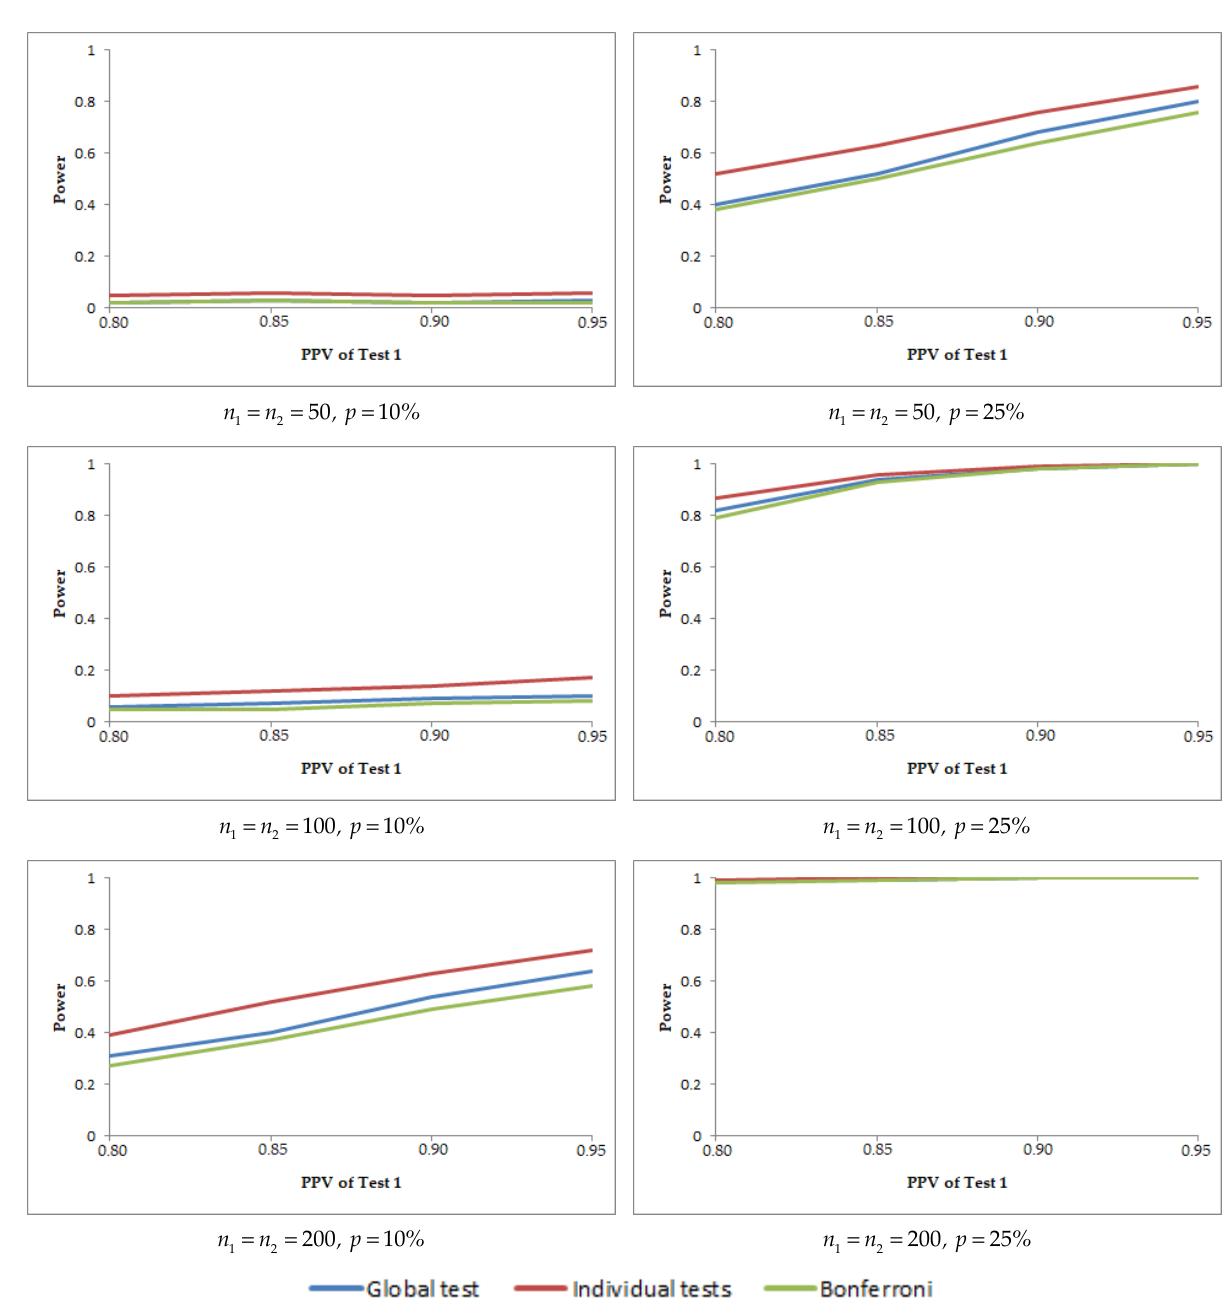
Figure 2. Powers of the three methods when the positive predictive value (PPV) of a binary diagnostic test varies and the rest of the PVs are constant.